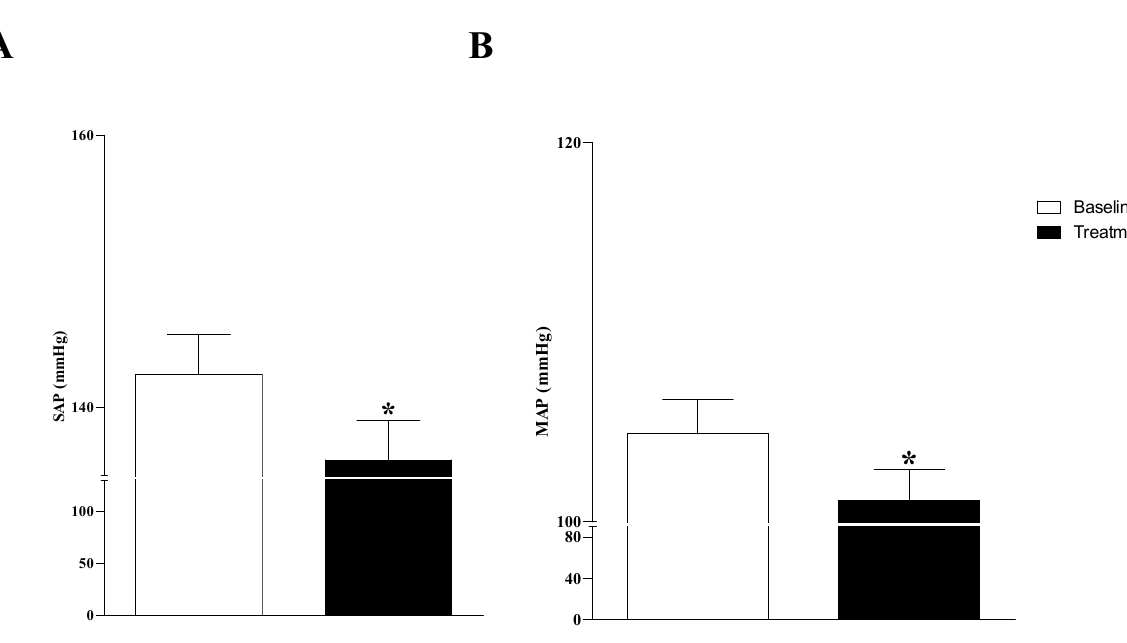
Figure 4. Systolic arterial pressure (SAP; panel ( A )) and mean arterial pressure (MAP; panel ( B )) on the baseline and after the treatment of denture-related stomatitis (DRS).